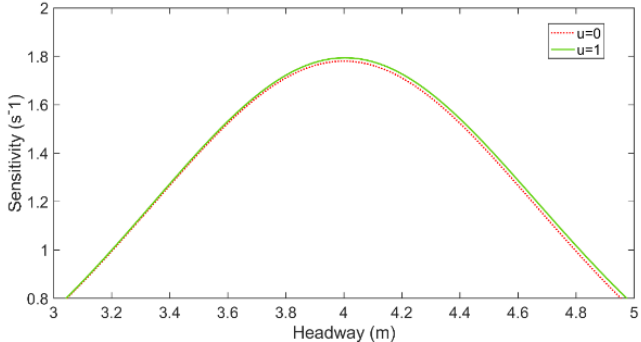
Figure 2. The stability curves in headway − sensitivity space.